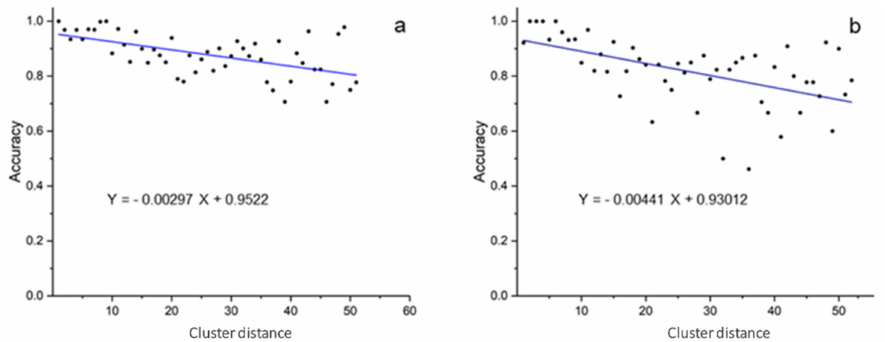
Figure 3. Graphical evaluation of the applicability domain by the plots of the accuracy (rate of correctly predicted instances) against the cluster distances for MT-dataset ( a ) and MQ-dataset ( b